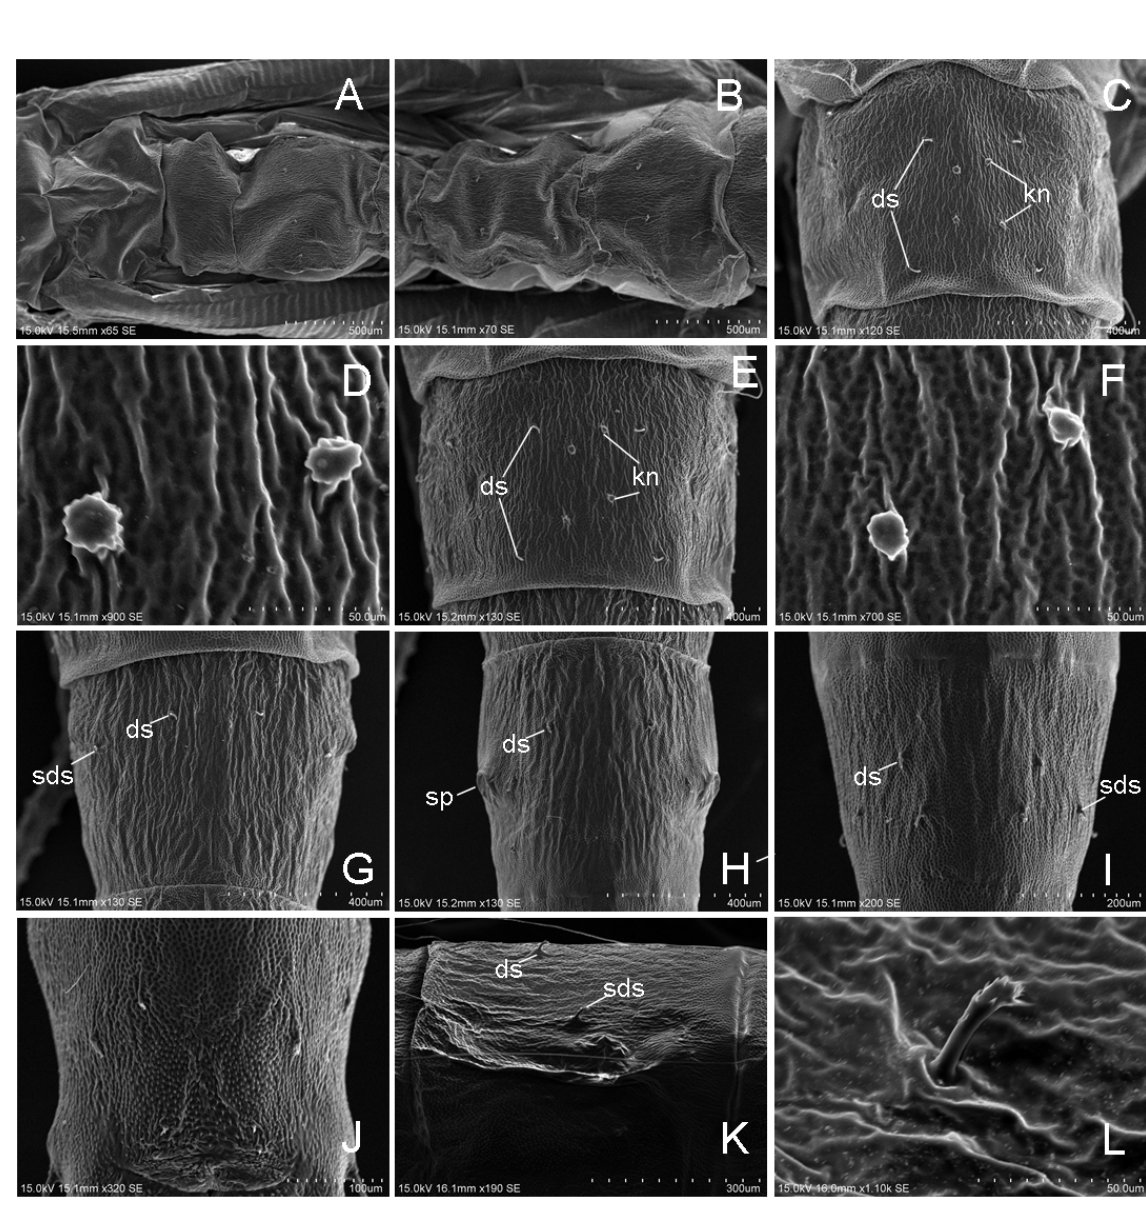
Fig. 11. SEMs of pupal abdomen of Tonza citrorrhoa Meyrick, 1905 (OPU-IN-LE2018IV0018 -0020). A–J. Dorsal view. K–L. Lateral view. A . A1–A2. B . A3–A4. C . A5. D . Anterior two minute knobs on A5. E . A6. F . Anterior two minute knobs on A6. G . A7. H . A8. I . A9. J . A10. K . A10. L . Subdorsal seta of A10. Abbreviations: ds = dorsal seta; kn = knob; sds = subdorsal seta; sp =